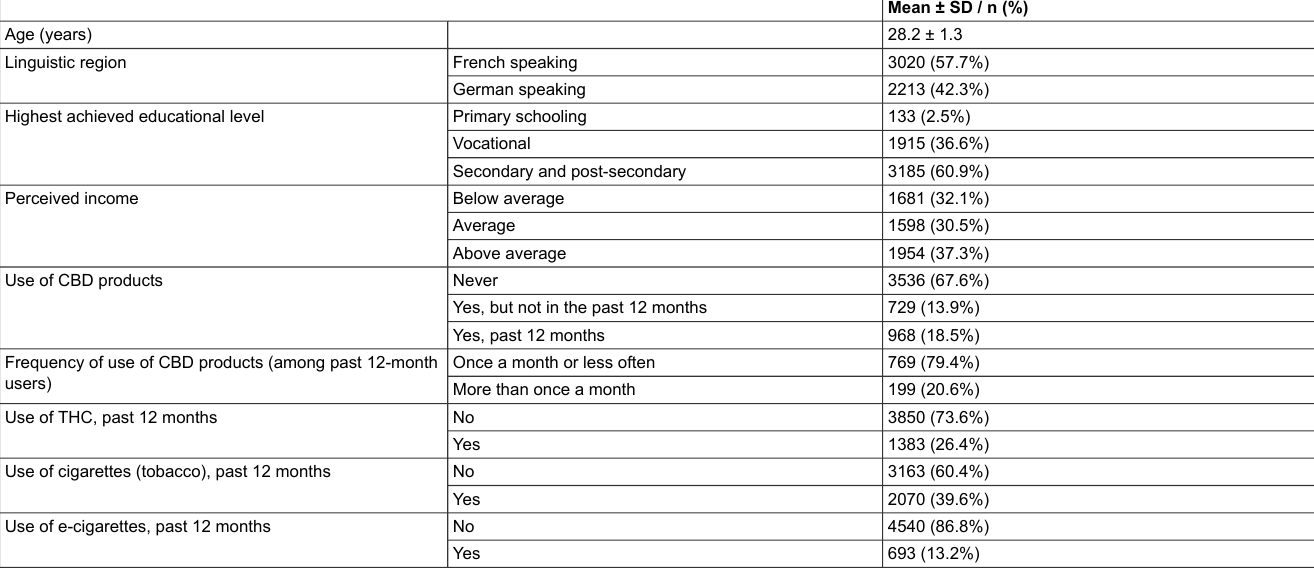
Table 1: Characteristics of the study sample (n = 5233).